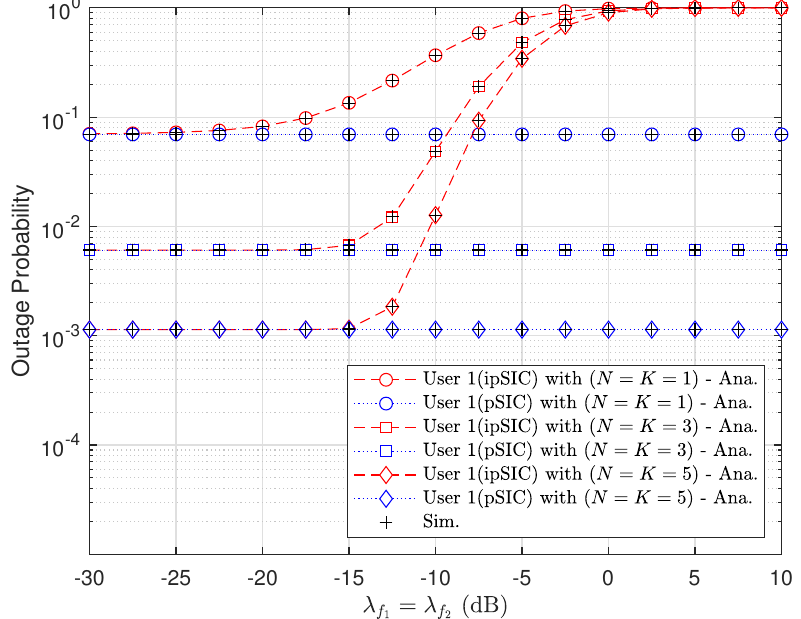
Figure 6. Impact of imperfect successive interference cancellation (SIC) levels to outage performance at the first vehicle with m = 3 and ρ = 20